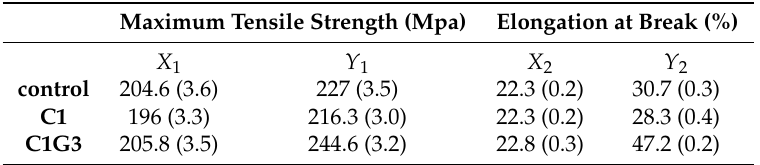
Table 2. Mechanical properties of control sample, CS and CS/Gr modified fabrics.